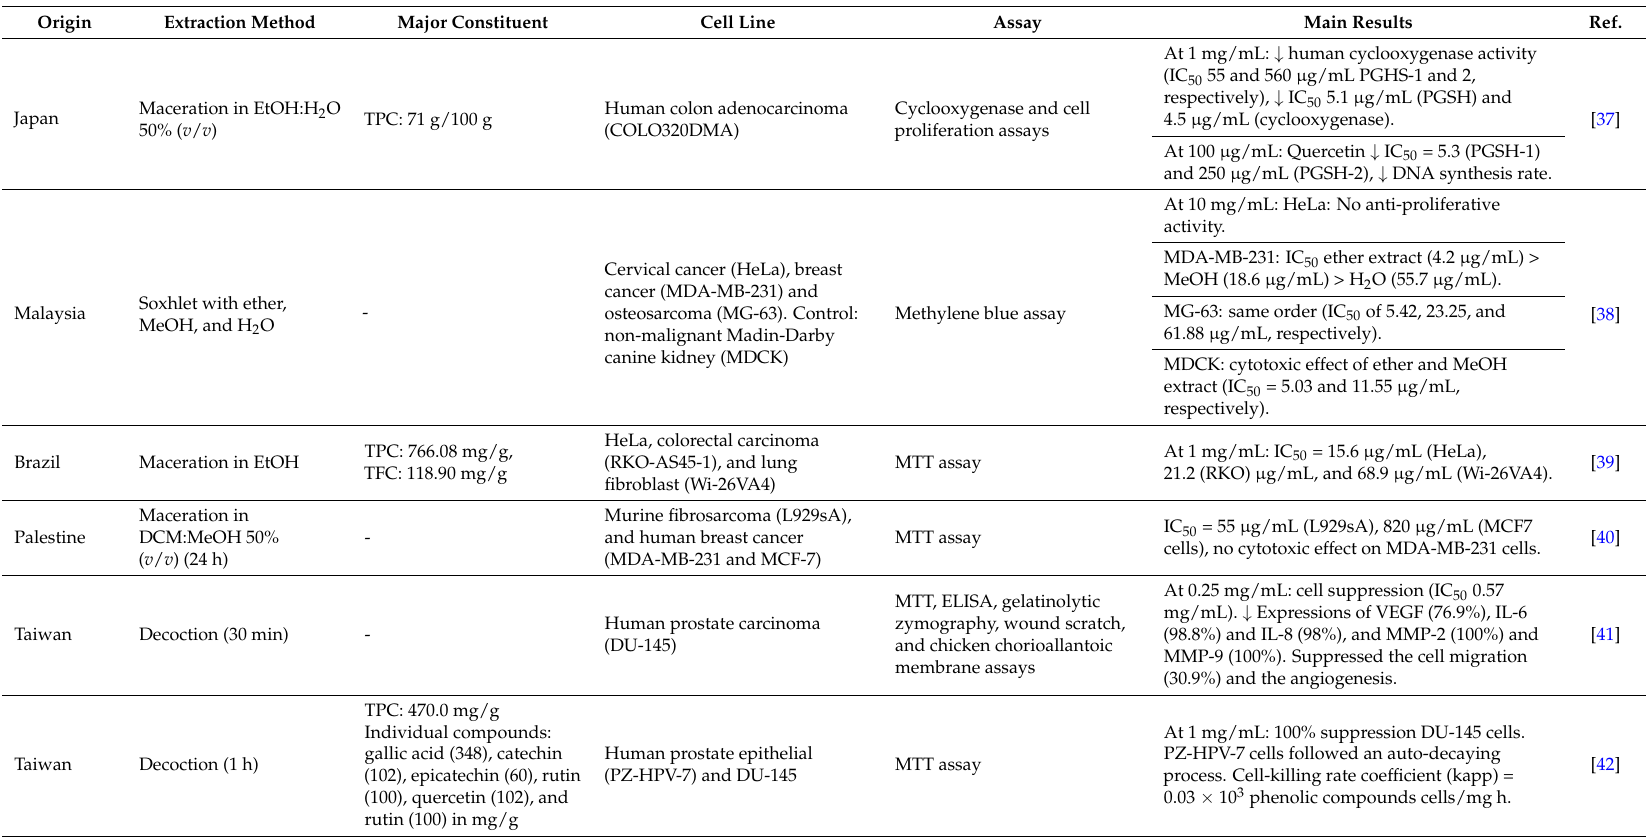
Table 2. In vitro studies against